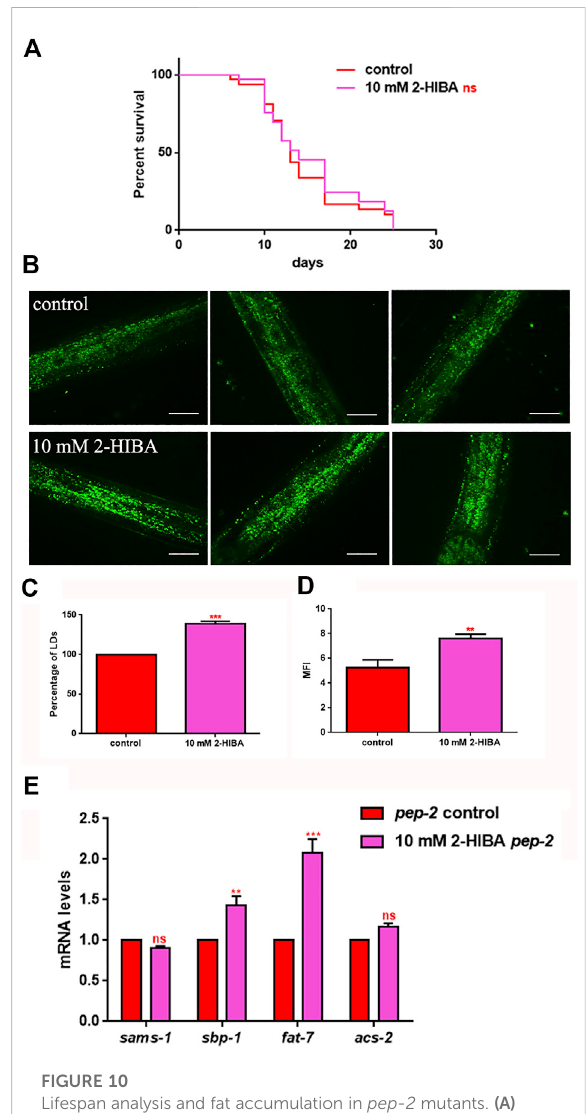
FIGURE 10 Lifespan analysis and fat accumulation in pep-2 mutants. (A) Kaplan-Meier survival plot of pep-2 mutant worms supplemented with 10 mM 2-HIBA. Lifespans of untreated worms were reported as controls; n = 60 for each data point of single experiments (ns: not signi fi cant). The assay was performed in triplicate. (B)